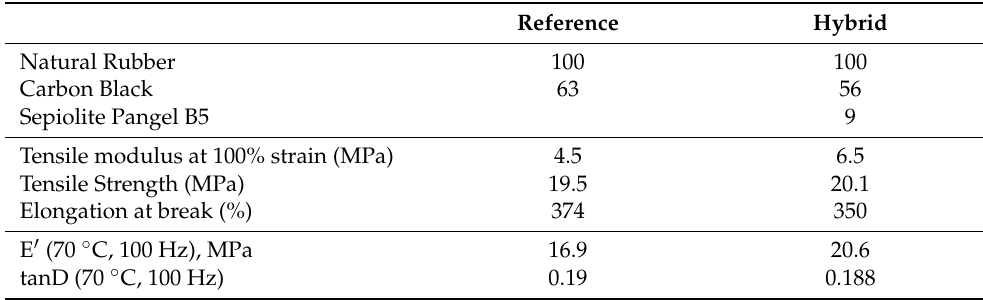
Table 1. Properties of formulation for tire undertread taken from ref.